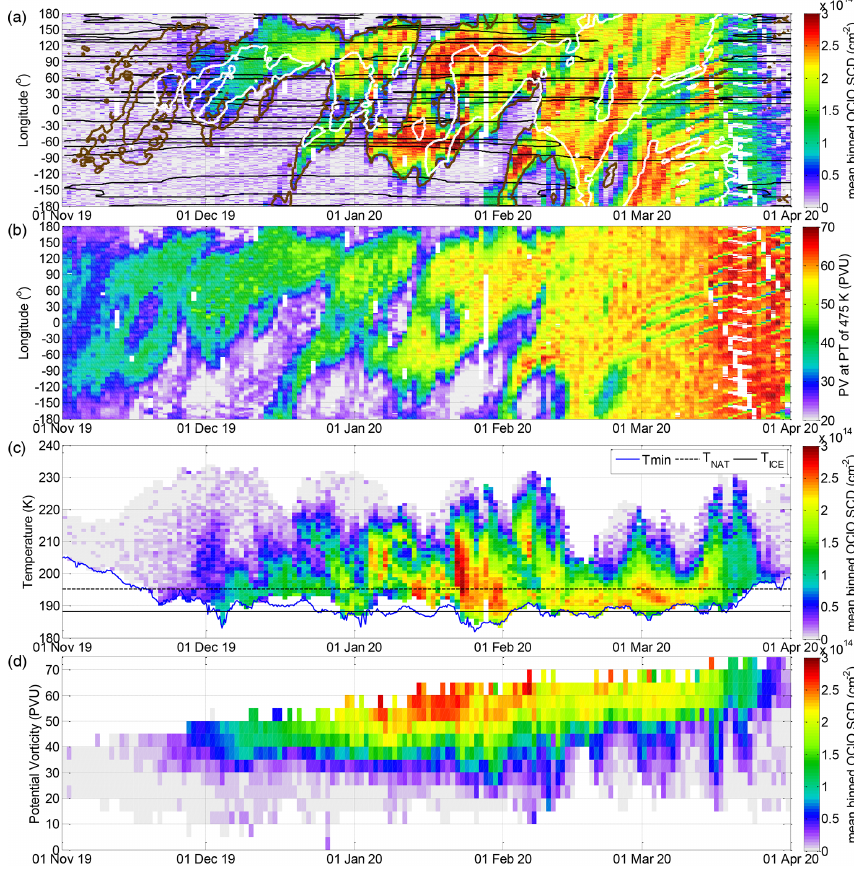
Figure 8. Same as Fig. 2 but for the Arctic winter